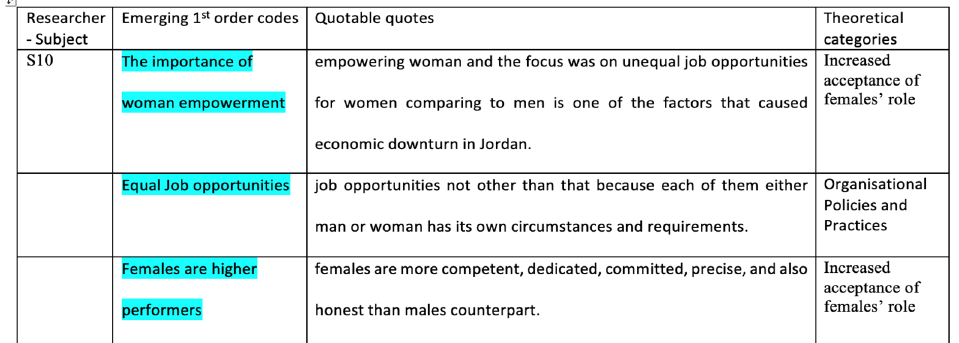
Figure 2. Sample axial coding.